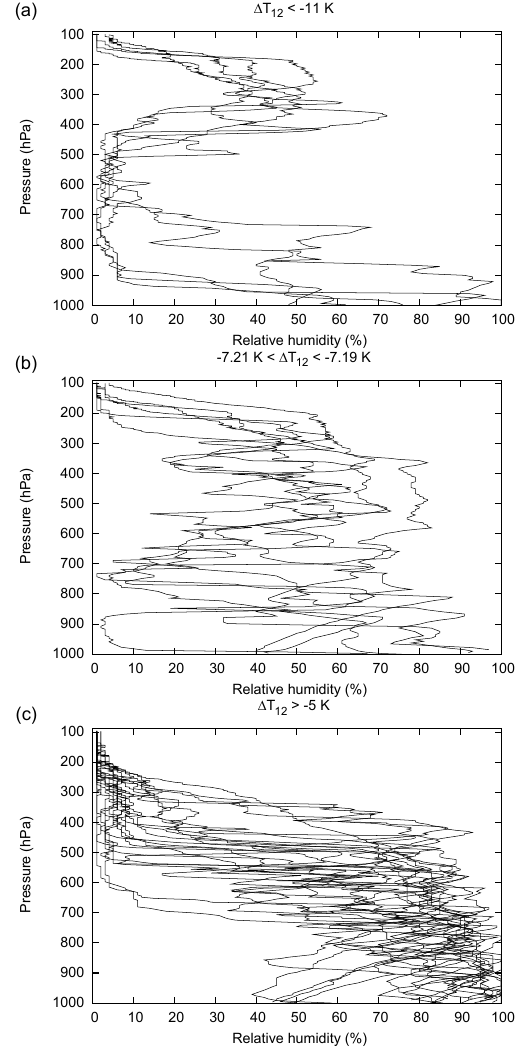
Figure 4. Lindenberg radiosonde profiles of relative humidity vs. pressure altitude that lead to brightness temperature differences in extreme ranges ( a, c , values indicated in the figures) and to values near to the mean (b) . The profiles are obtained from the following launches (format yymmddhh): 00042806, 00122312,